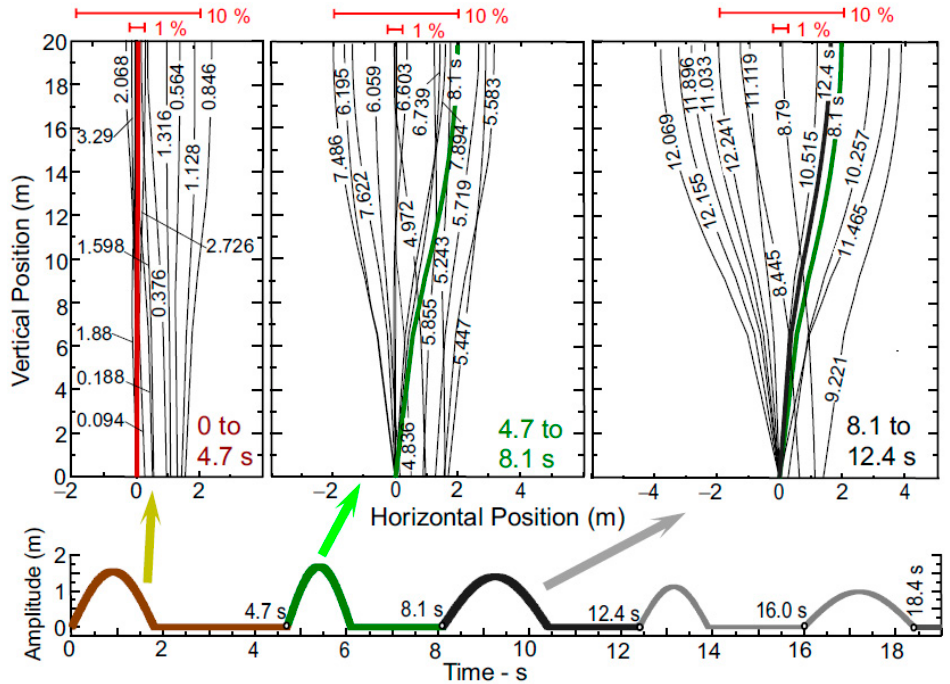
Figure 14. Model displacements during the first three pulses, which, after the third pulse, exceed a 10% drift. Roof displacements corresponding to 1% and 10% drifts are shown with red lines above the figure. Consecutive displacements of the building are shown during the first three pulses. The duration times corresponding to the plotted configuration are shown in seconds.